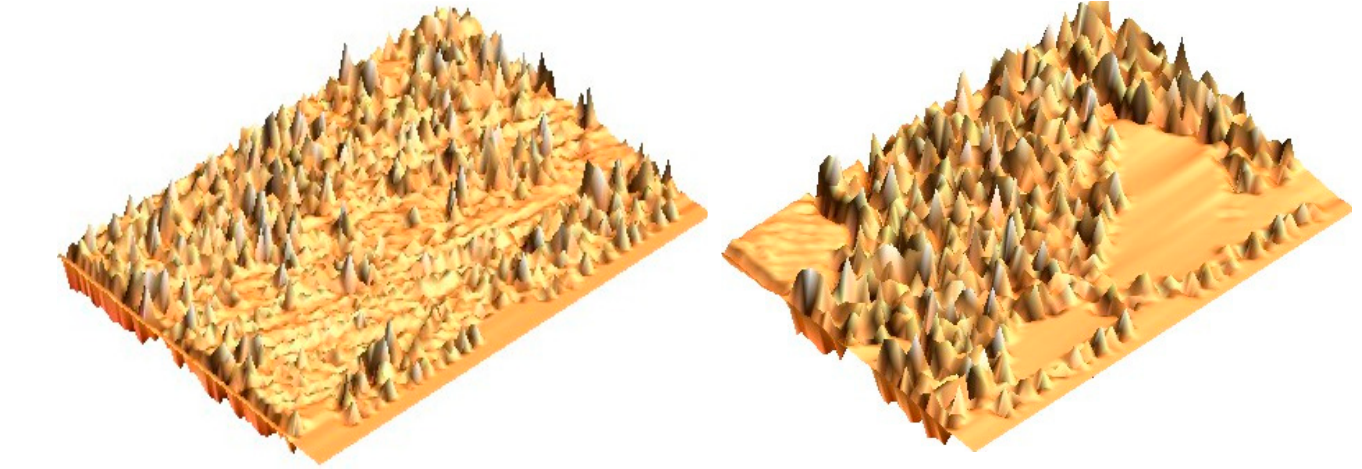
Figure 6. AFM images and roughness studies of and [PoPDA/TiO 2 ] MNC .